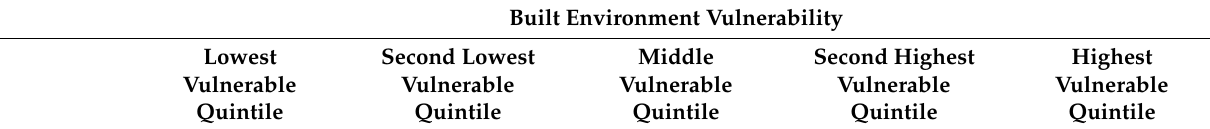
Table 4. Neighborhood socio-demographic characteristics by built environment